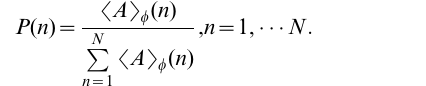
( t ) and the amplitude i